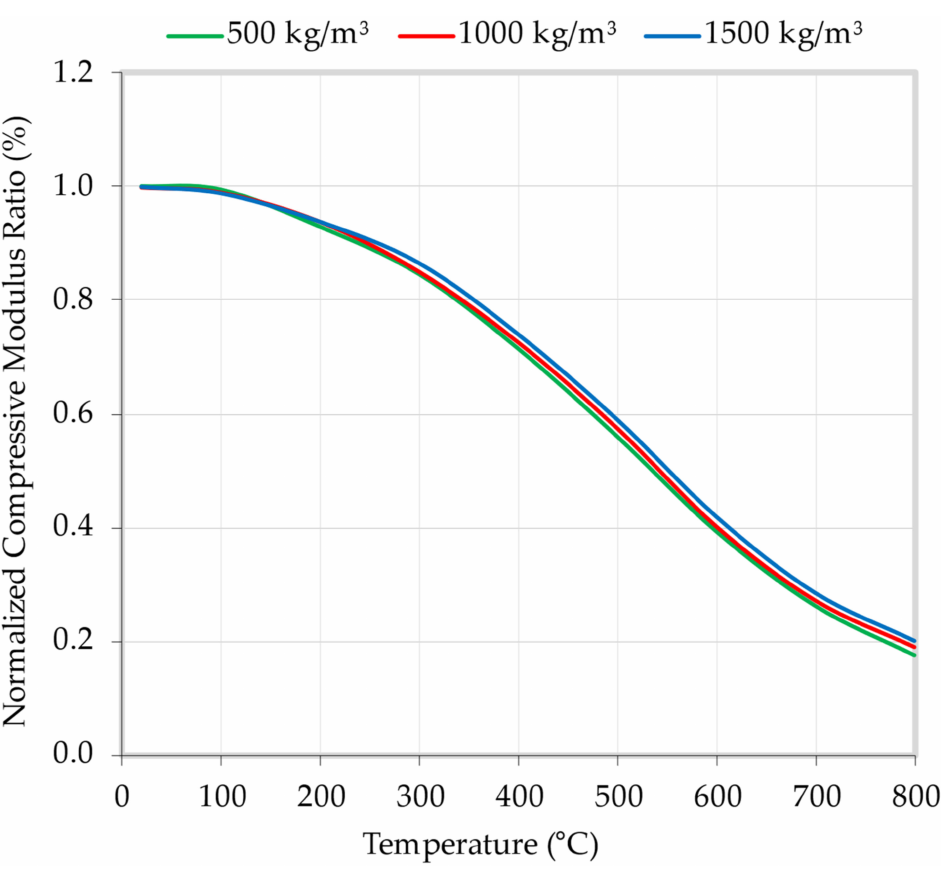
Figure 14. Influence of varying temperatures on the normalized LFC compressive